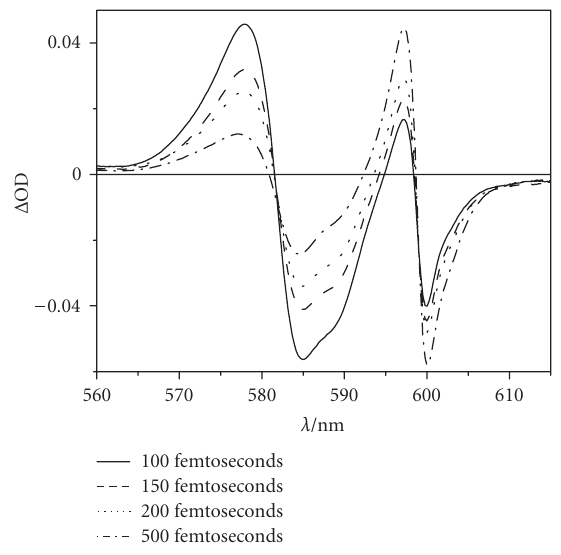
Figure 8: Dynamics of the pump-probe spectrum of pure C8O3 aggregates during the first 500 femtoseconds after excitation at 580